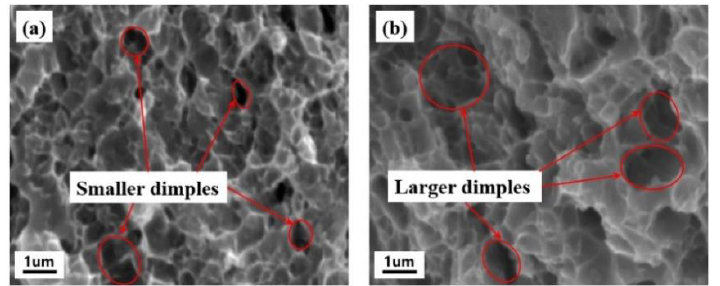
Figure 11. Tensile fracture morphologies of 40CrMo steel. ( a ) untreated sample and ( b ) LSP sample.